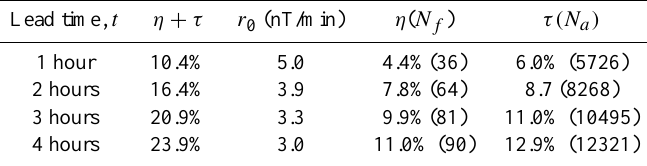
Table 3. Optimal threshold for issuing an alarm r 0 , cost value γ = n + τ , failure ratio n and number of failures to predict ( N f ), alarm ratio τ and total hours of alarm ( N a ) for an extreme event threshold R 0 fixed to 20 nT/min and for a prediction with a lead time